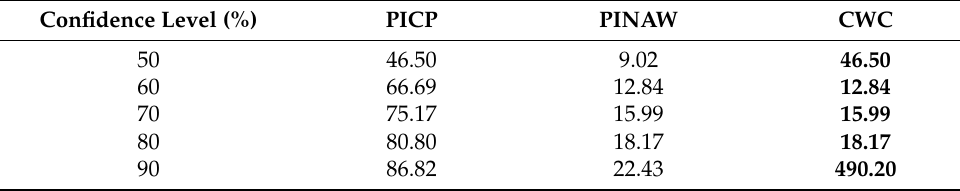
Table 7. Three-hour-ahead PIs using Method 3. Confidence Level